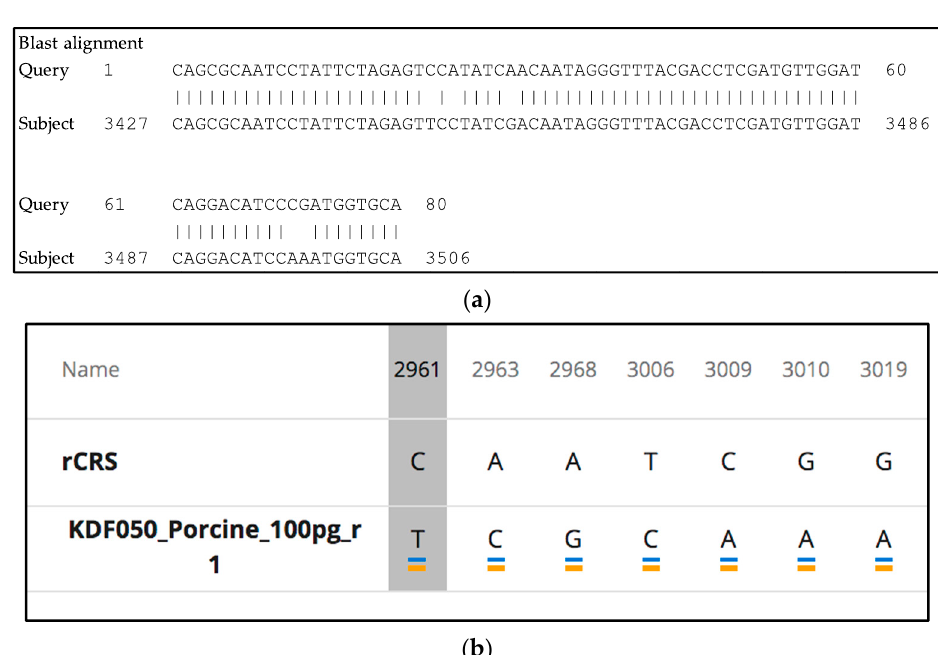
Figure 6. Species-specificity study: ( a ) basic local alignment search tool (BLAST) results for targeted human mtDNA amplicon (query) and porcine genome coordinates (subject, 3427–3506), ( b ) UAS screenshot of variant positions between the rCRS and the one amplicon detected in the replicate porcine libraries.